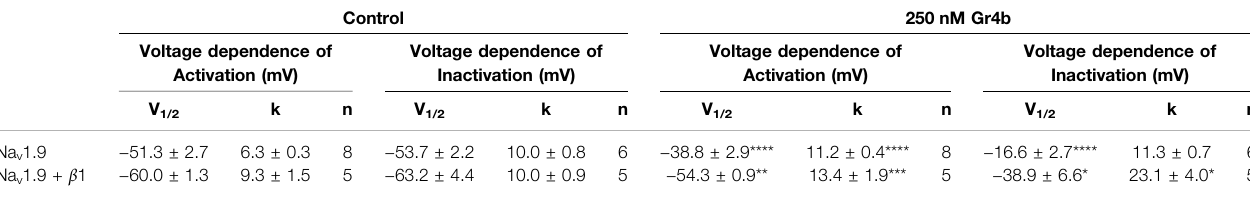
TABLE 1 | The effects of Gr4b on activation and inactivation of Na v 1.9. Control Voltage dependence of Activation (mV)